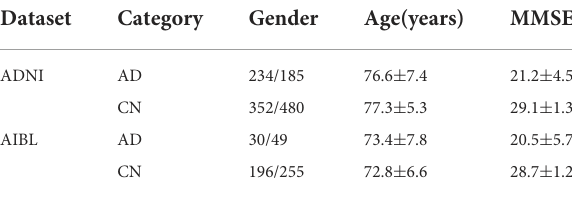
TABLE 2 Demographic data of subjects included in the